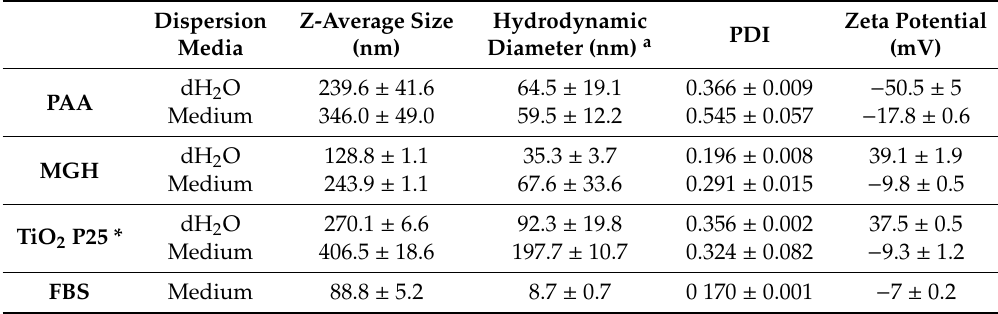
Table 1. Z-average size, hydrodynamic diameter, polydispersity index (PDI) values and Zeta potential of industrial-grade TiO 2 P25, maghemite (MGH) and polyacrylic acid (PAA) coated cobalt ferrite nanoparticles in distilled water and DMEM cell culture medium supplemented with 10% foetal bovine serum (FBS). Mean and standard deviation are shown for two separate